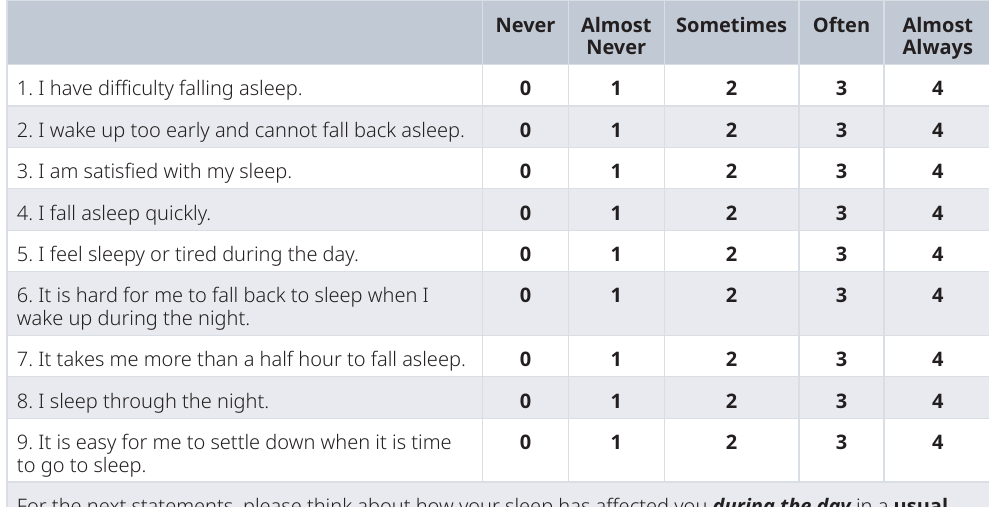
Table 1. Adolescent Insomnia Questionnaire, English